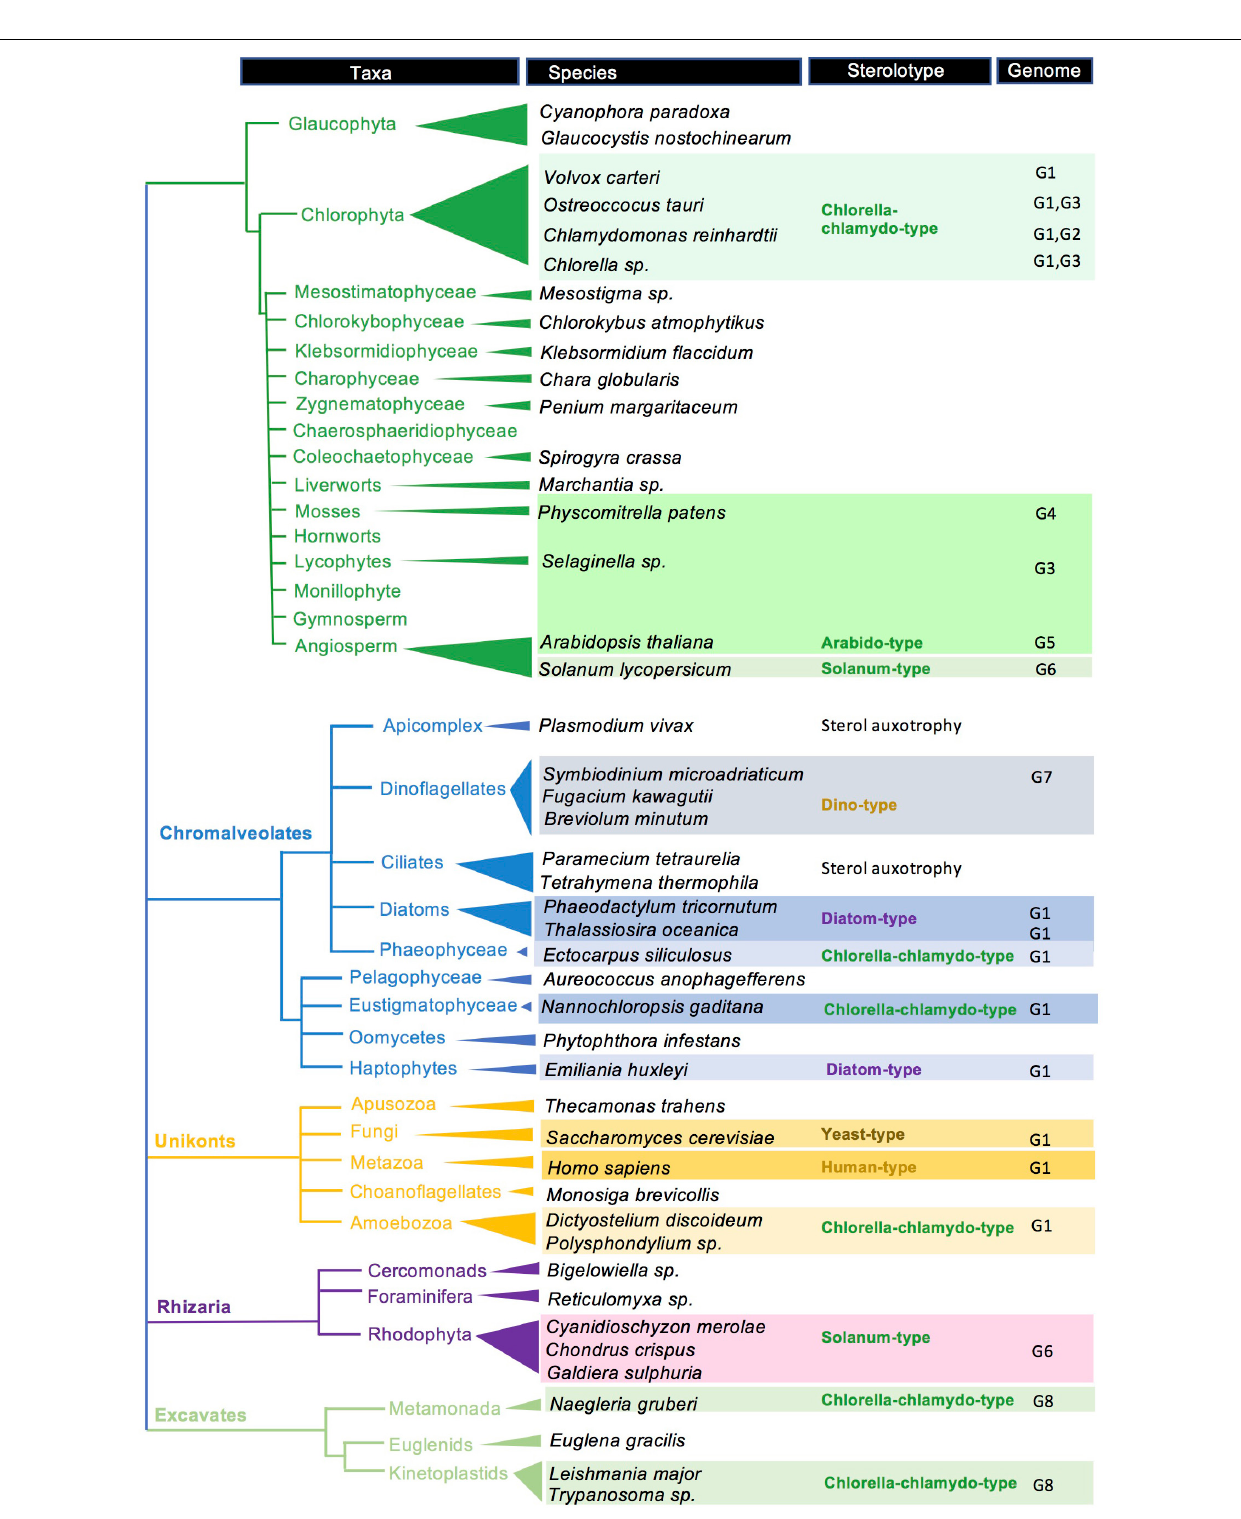
FIGURE 7 | Sterolotype distribution over a tree of eukaryotes. A selection of species is tagged with sterolotypes presented in Figure 2 . References about genomes and gene functions, and sterol profiles, are indicated by G1 to G8. G1, (Lu et al., 2014); G2, (Brumfield et al., 2017); G3, (Gold et al., 2016); G4, (Morikawa et al., 2009); G5, (Schaller, 2010); G6, (Sonawane et al., 2016); G7, (Lu et al., 2020); and G8, (Fügi et al., 2014). Species with no sterolotype indications are awaiting for a comprehensive mining of corresponding genomes. Gene nomenclature for Arabidopsis thaliana , Saccharomyces cerevisiae , Homo sapiens, and Chlamydomonas reinhardtii is given in Supplementary Table 1